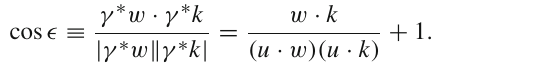
diagram of celestial coordinates can be obtained in Fig.